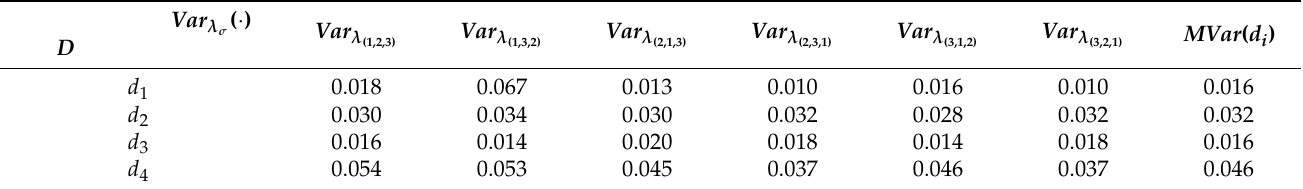
Table 4. Associated variances and monotone variances for the alternatives d i , i = 1, . . . ,4.